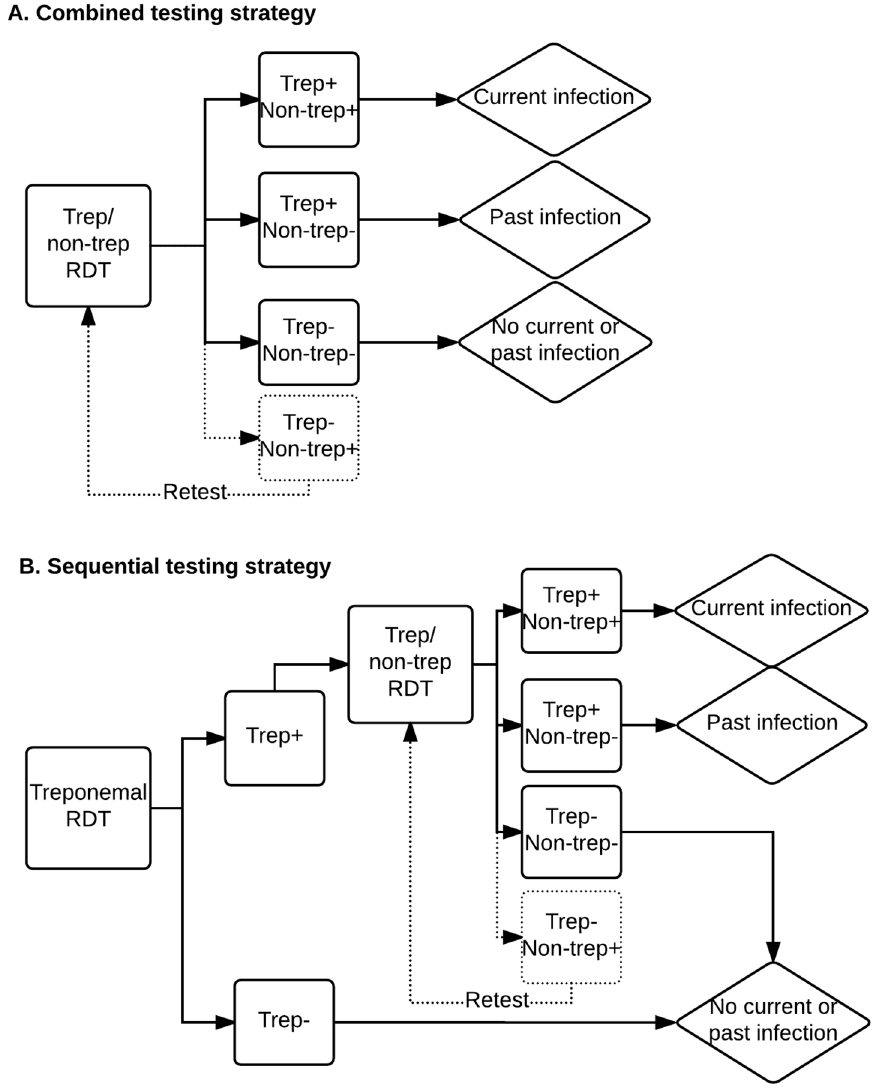
Fig 1. Diagram of alternative testing strategies: Combined (panel A) and sequential (panel B). Boxes representtests and test results; diamonds represent diagnoses; dotted lines representdiscordanttreponemal and non-treponemal test results by the trep/non-trep RDT, excludedfrom Fig 2 for simplicity; in the case of discordant results betweenthe treponemal RDT and the trep/non-trep RDT, the sequential testing strategy takes the result of the trep/non-trep